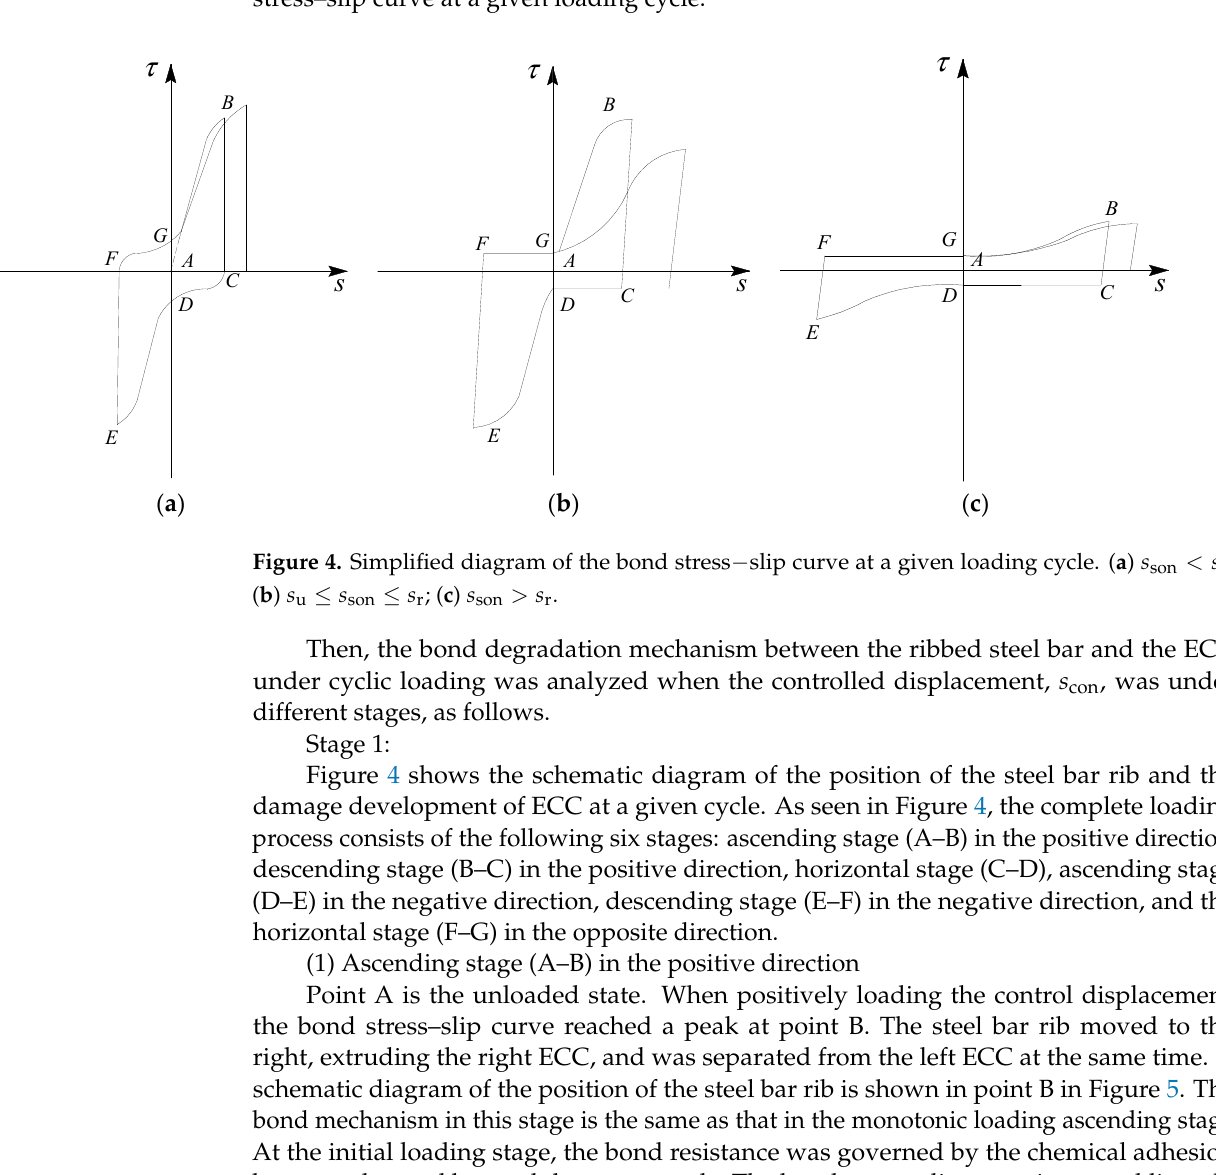
Figure 3. Typical bond stresss–lip curves of the specimens under monotonic and cyclic loading. τ and τ − are the positive and negative peak bond stresses As shown in Table 2, + u u τ and τ − are the positive and negative residual under cyclic loading, respectively. + r r As shown in Table 2, τ + and τ − are the positive and negative peak bond stresses under u u τ and m τ are the ultimate bond bond stresses under cyclic loading, respectively. m cyclic loading, respectively. τ + and τ − are the positive and negative residual bond stresses u r r r strength and residual bond strength under cyclic loading, respectively ( under cyclic loading, respectively. τ m and τ m are the ultimate bond strength and residual u r τ and τ are the ultimate bond strength and residual bond strength = ( τ + + τ − ) /2, τ m = ( τ + + τ − ) /2). ). bond strength under cyclic loading, respectively ( τ m u u u r r r u r τ u and τ r are the ultimate bond strength and residual bond strength under monotonic under monotonic loading, respectively. K r is the ratio of residual bond strength to ultimate λ is the degradation coefficient of ultimate loading, respectively. K r is the ratio of residual bond strength to ultimate bond strength bond strength under monotonic loading. u under monotonic loading. λ u is the degradation coefficient of ultimate bond strength under bond strength under cyclic loading. cyclic loading.